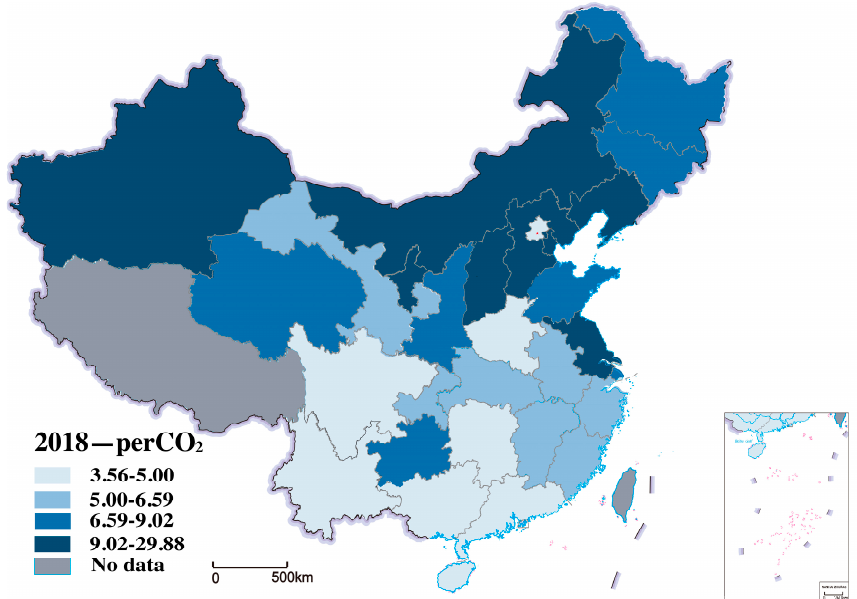
Figure 3. Distribution of carbon emissions per capita in 2018.